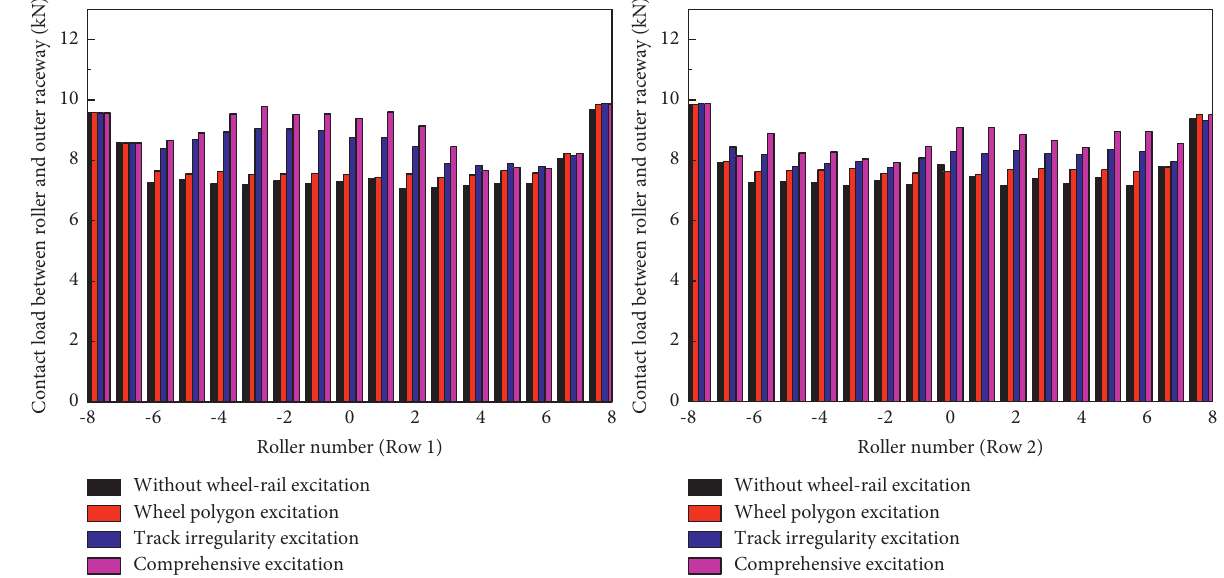
Figure 20: Maximum amplitude of roller-outer raceway contact